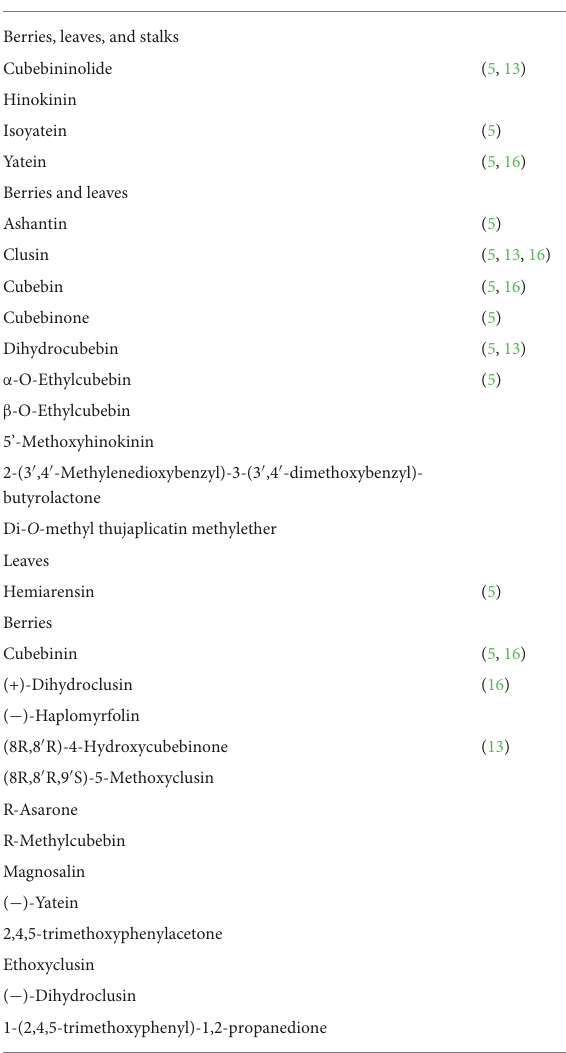
TABLE 2 Identified lignans from P.